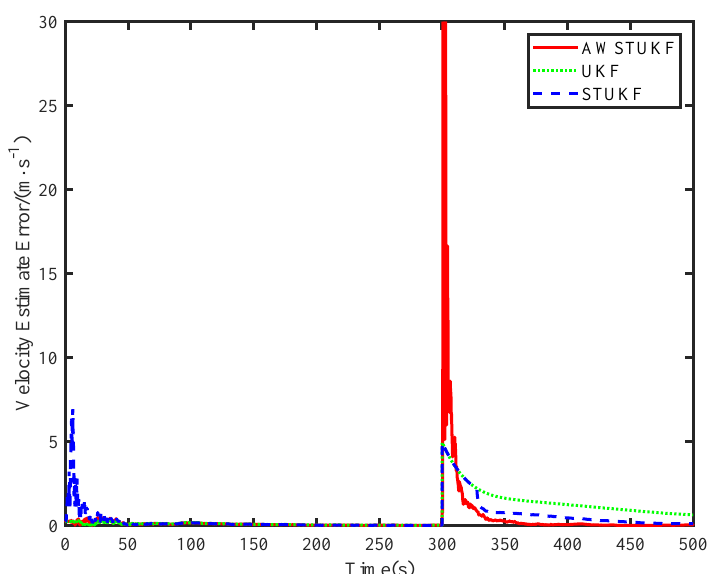
Figure 4. Velocity estimate errors of different methods.